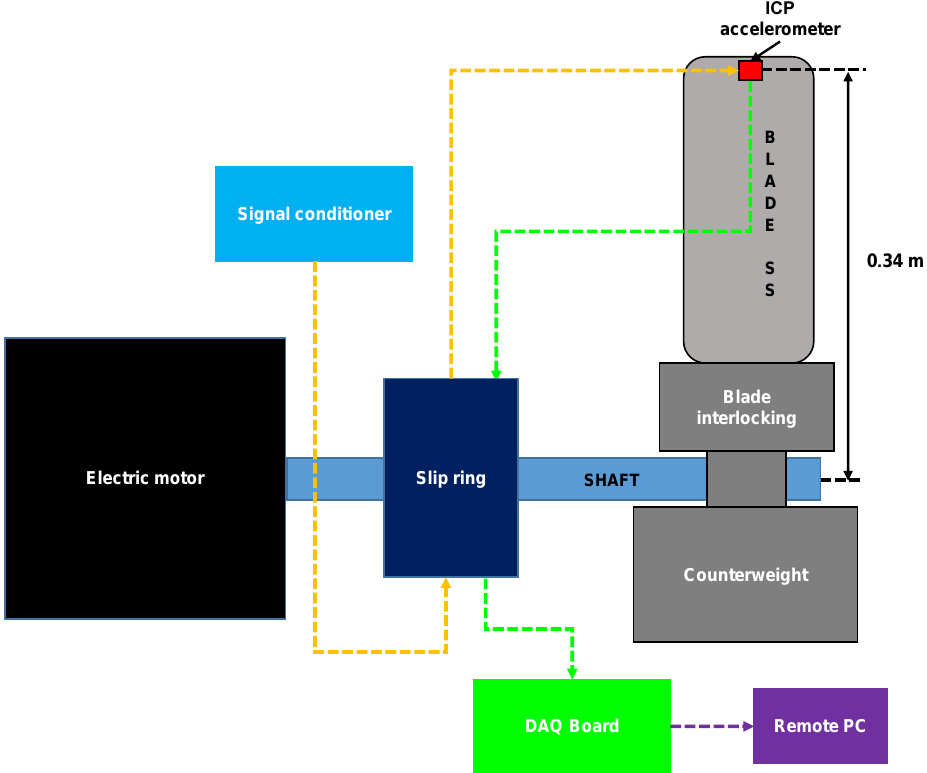
Figure 2. Functional scheme of the reference vibration monitoring system. The reference accelerome- ter mounted on the blade tip suction surface (SS) is powered by a signal conditioner via the slip ring wires. The signal conditioner is wired to the data acquisition board that is controlled by a remote PC by means of a LabView